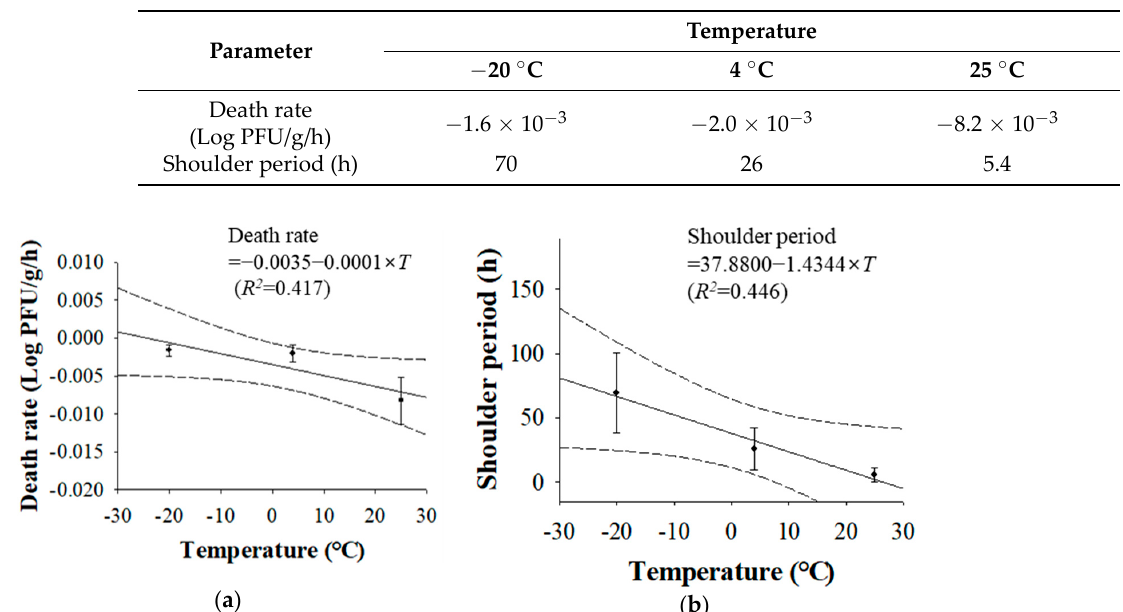
Figure 2. Secondary predictive models for hepatitis A virus death rate ( a ) and shoulder period ( b ) in fermented clams by temperature ( T : temperature; • : observed data; ―: fitted line). The changes in the HAV contamination level in the fermented clams simulated by the developed predictive models with the probabilistic distributions of temperature and time during transport and storage are presented in Figure 3. When the initial contamina- tion level went through the market (C1)—transfer from market to house (C2)—storage at the house (C3), the average predicted HAV contamination level slightly decreased from − 6.7 to − 7.8 Log PFU/g. Figure 3. Changes in hepatitis A virus contamination level in the fermented clams according to transportation and storage. 3.4. Consumption Ratio and Amount of Fermented Clams Nine participants stated they ate ‘fermented clam (Jogaejeotgal)’ out of a total of 7,064 who took the KNHANES in 2018. Accordingly, 0.13% of South Koreans consumed fer- mented clams, and they consumed 9.77 g on average. The optimal probability distribution for the consumption amount was the Exponential distribution [Expon(8.1789, Shift(0.69235))] (Figure 4).